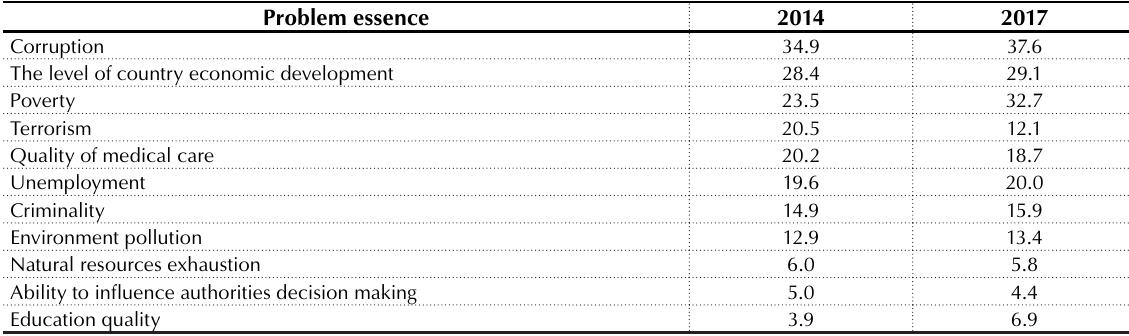
Table 3. Dynamics of the most important problems for Ukraine, %